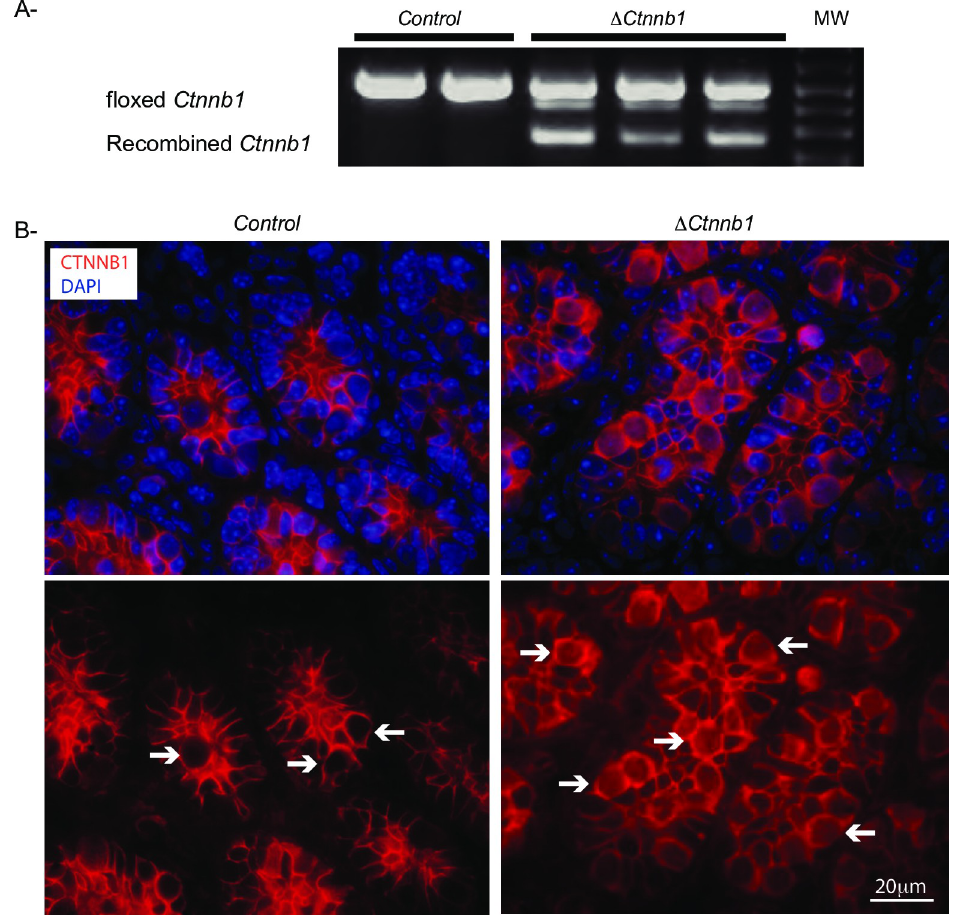
Fig 1. CTNNB1 stabilization in Δ Ctnnb1 mice. A) RT-PCR analyses of Ctnnb1 in testes from 5 day-old Δ Ctnnb1 and control mice. As indicated, a shorter RT-PCR fragment is produced from transcripts derived from the recombined Ctnnb1 tm1Mmt allele. B) Immunofluorescence analysis of CTNNB1 expression in testes from 5 day-old Δ Ctnnb1 and control mice. Scale bar (lower right) is valid for all images. Arrow = germ